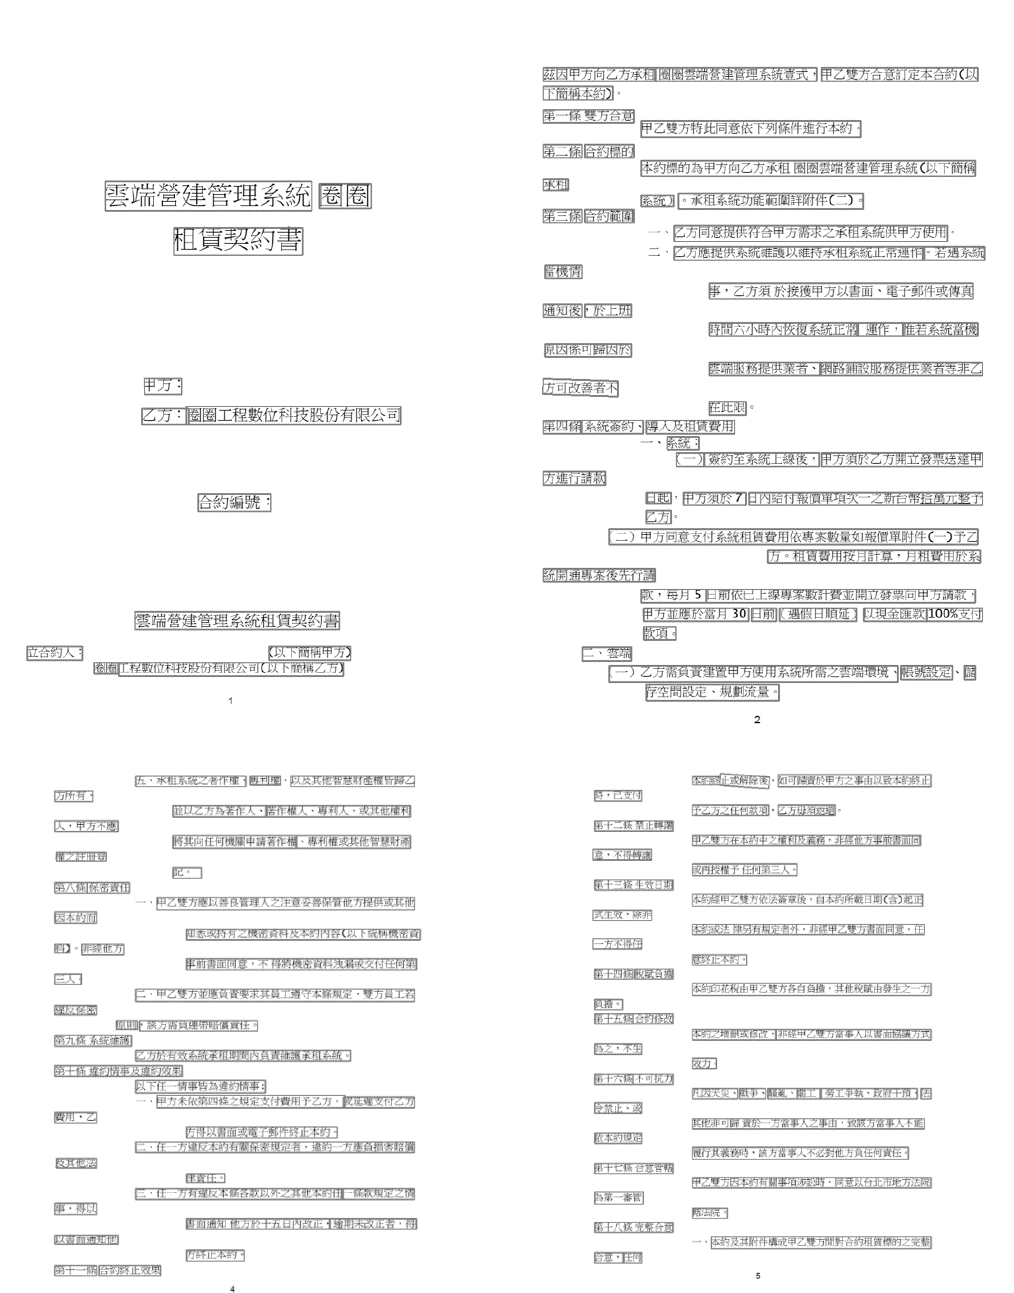
Figure A1. PSENet Test Chart (Original Chinese contract segmented using PSENet method).